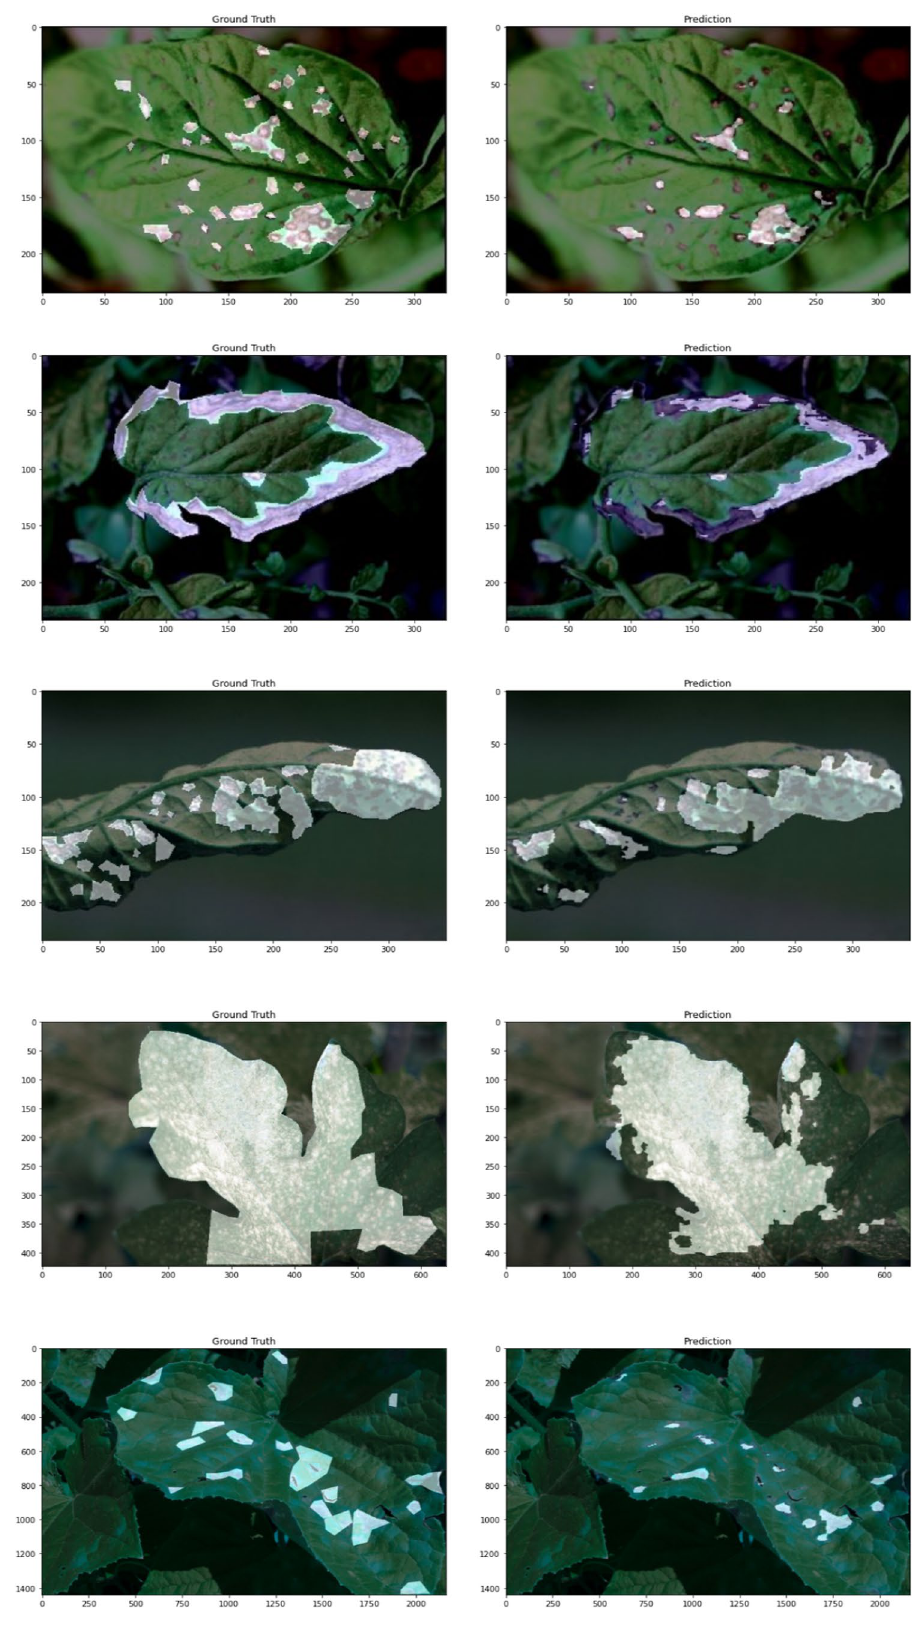
Fig. 6 Some Ground Truth against prediction samples obtained by